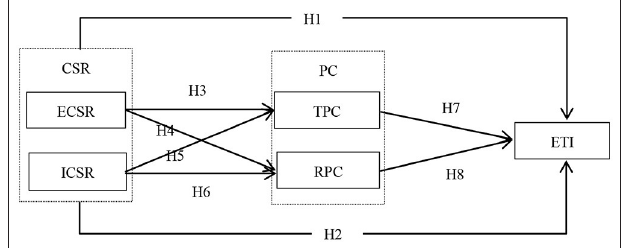
FIGURE 1 | Theoretical model